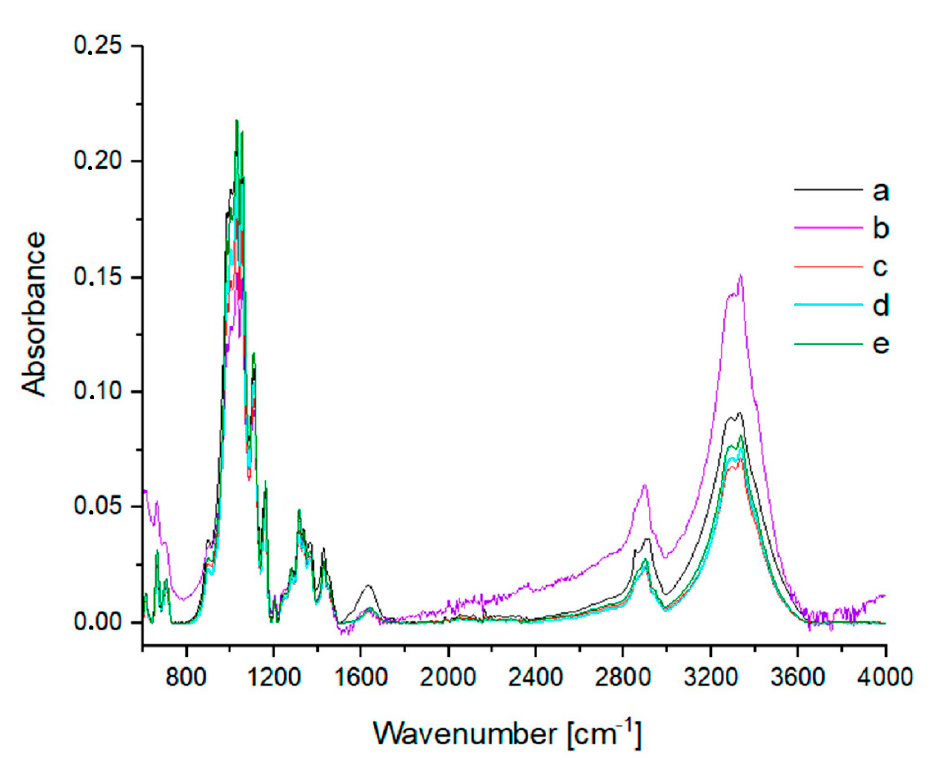
Figure 8. IR spectra of ( a ) washed cotton and cotton treated at 120 ◦ C for 2 h with various concentrations of H 2 SO 4 : ( b ) 0.5%; ( c ) 2%; ( d ) 5%; ( e ) 10%.